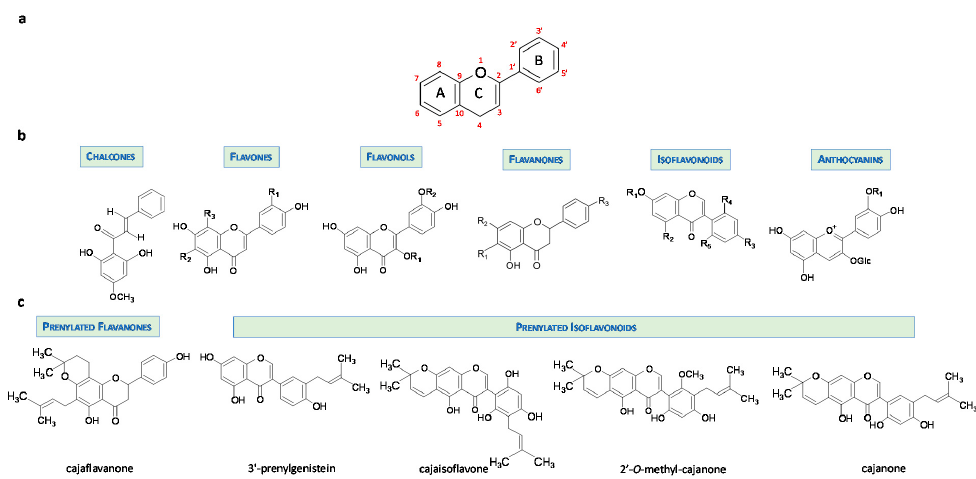
Figure 3. ( a ) Classical C6-C3-C6 chemical backbone and atom numbering of flavonoids. ( b ) Structures